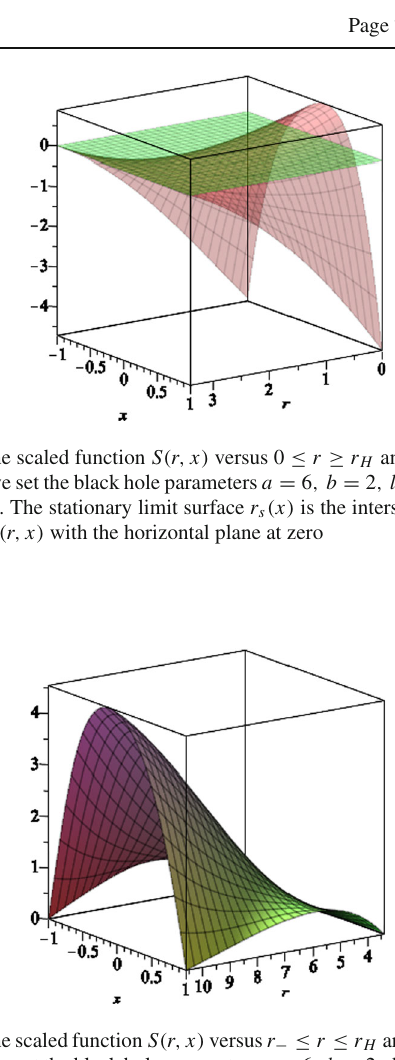
field, outside the event horizon, for a black hole with param- eters a = 6 , q = 1 , m = 7 , l = 1 and b = 2.